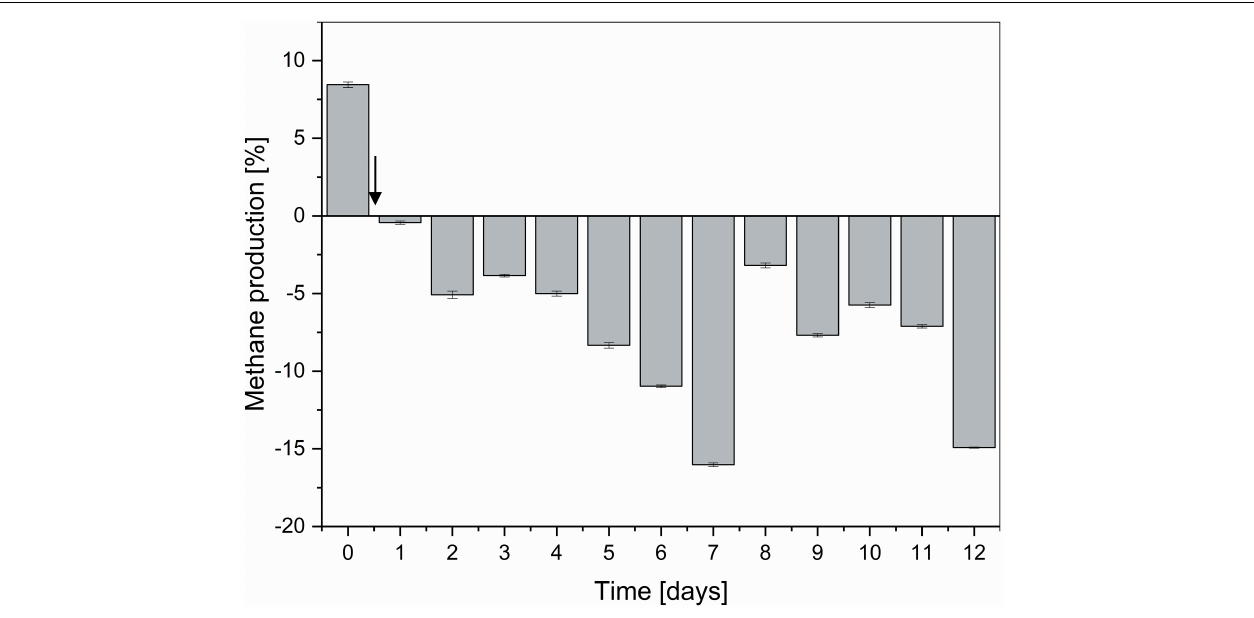
FIGURE 5 | Degree of methane reduction in a continuous flow fermentation system. Methane inhibition as compared between non-functionalized and dual-fusion PeiR nanoparticles is expressed as percent inhibition over the course of 12 days. The vertical arrow indicates the start of nanoparticle addition to reactor vessels. Error bars represent the standard errors of two reactor vessels with 96 daily methane measurements